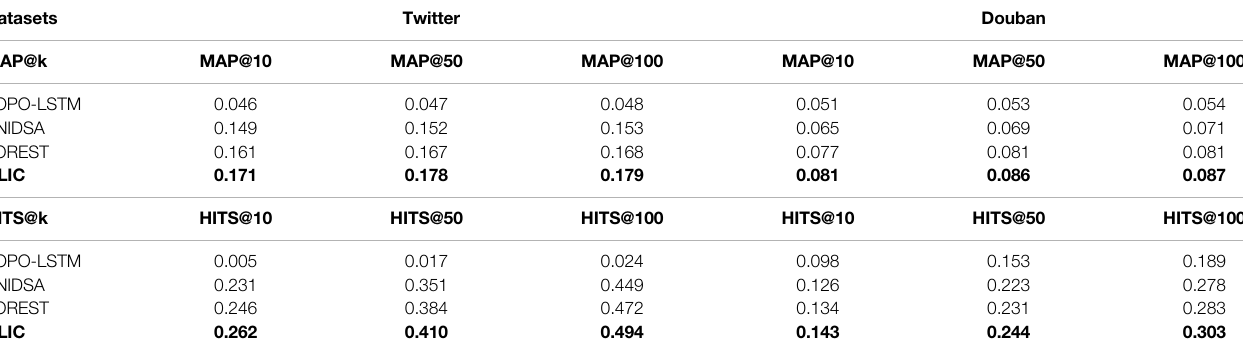
TABLE3| ExperimentalresultsofourproposedmodelonTwitterandDouban.ResultsareevaluatedbyMAP@kandHITS@kindifferentcategoriesofmodelonthecascade prediction task. For both metrics, scores are the higher the better.